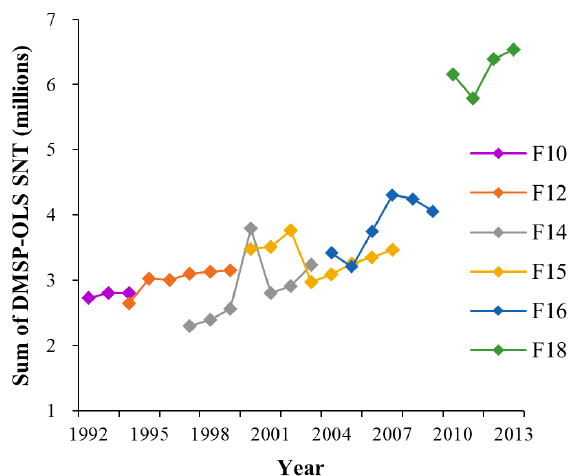
Figure 2. Sum of DN values of lit pixels from the Defense Meteorological Satellite Program Operational Line-Scan System of stable night-time (DMSP-OLS SNT) light images for Saudi Arabia.